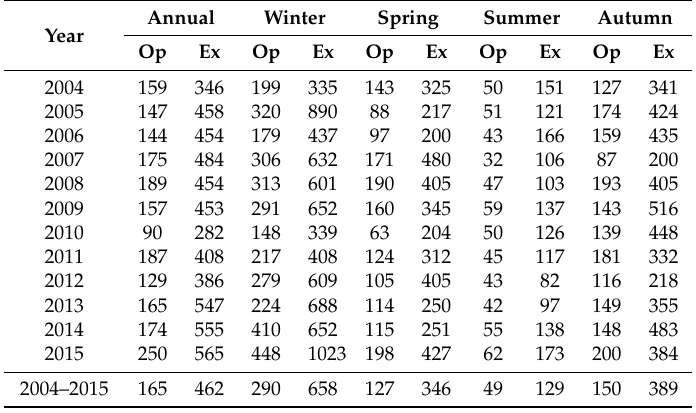
Table A11. Annual and seasonal Op and Ext P thresholds (kW/m) at